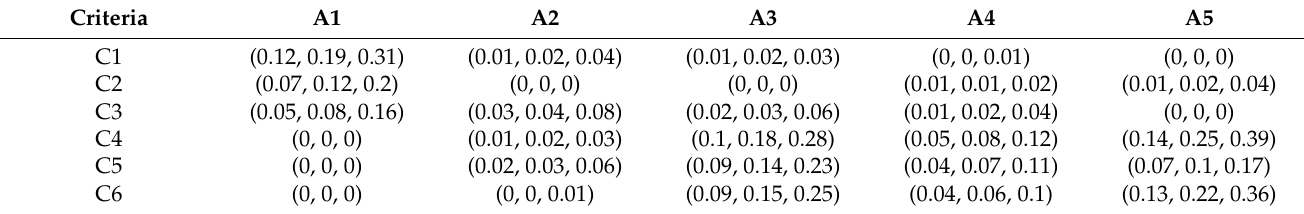
Table 9. The weighted fuzzy synthetic normalized rating matrix.